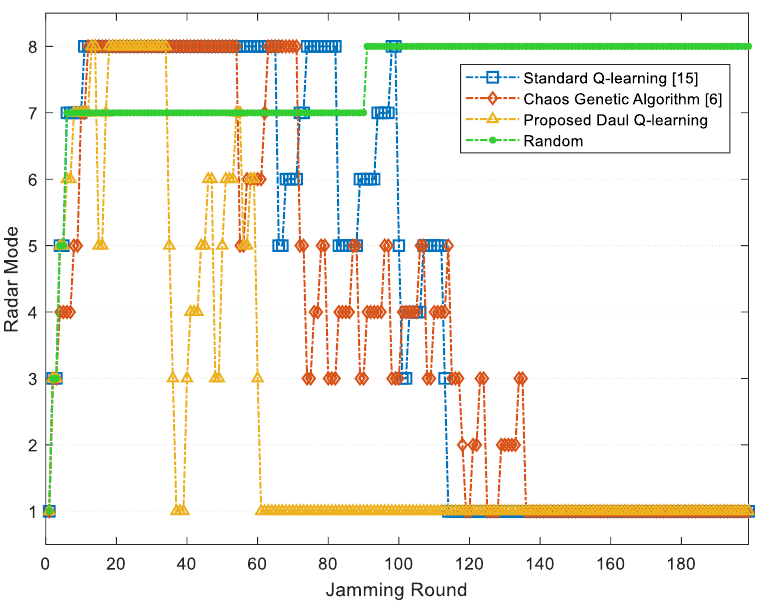
Figure 7. Radar mode switching comparison among different methods: radar modes 1 to 8 represent M r to M r 8 1